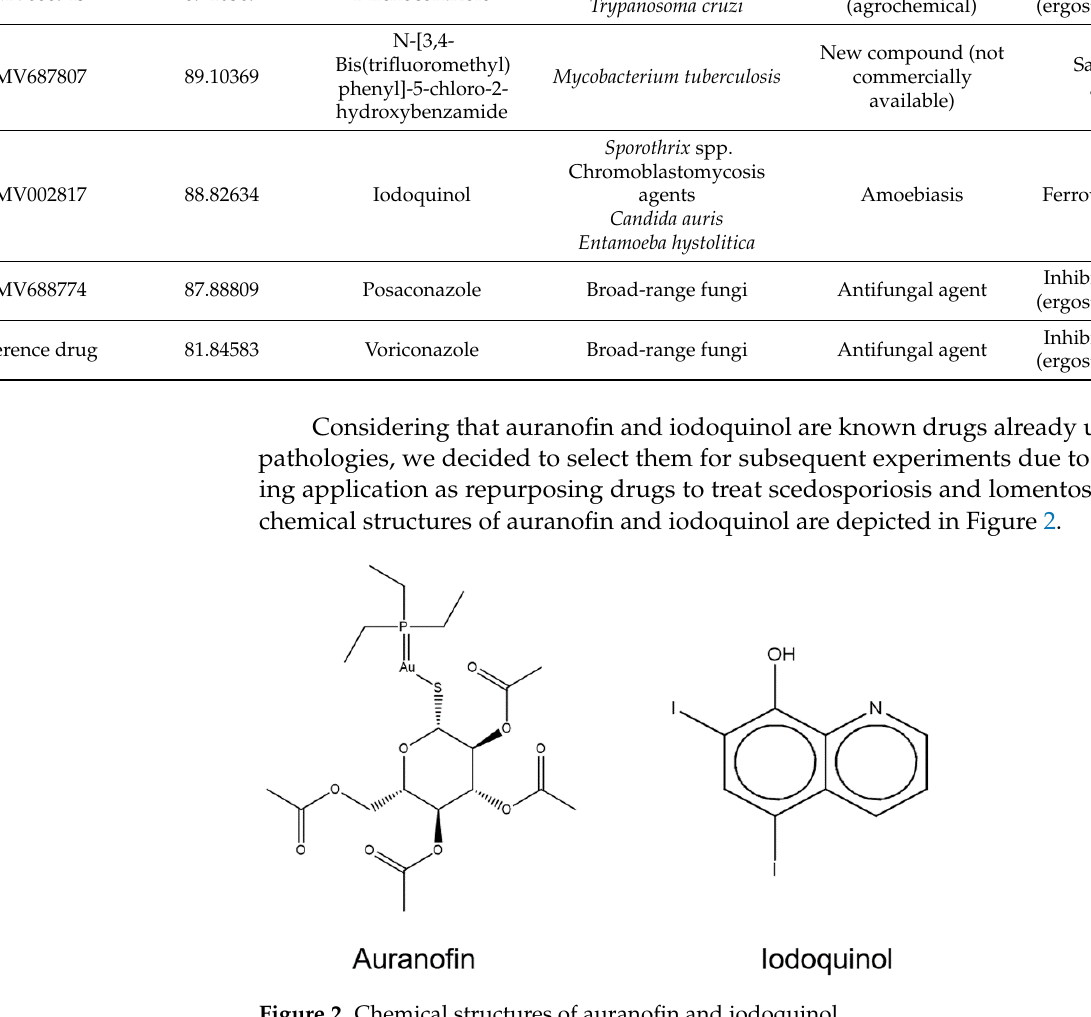
Figure 2. Chemical structures of auranofin and iodoquinol.